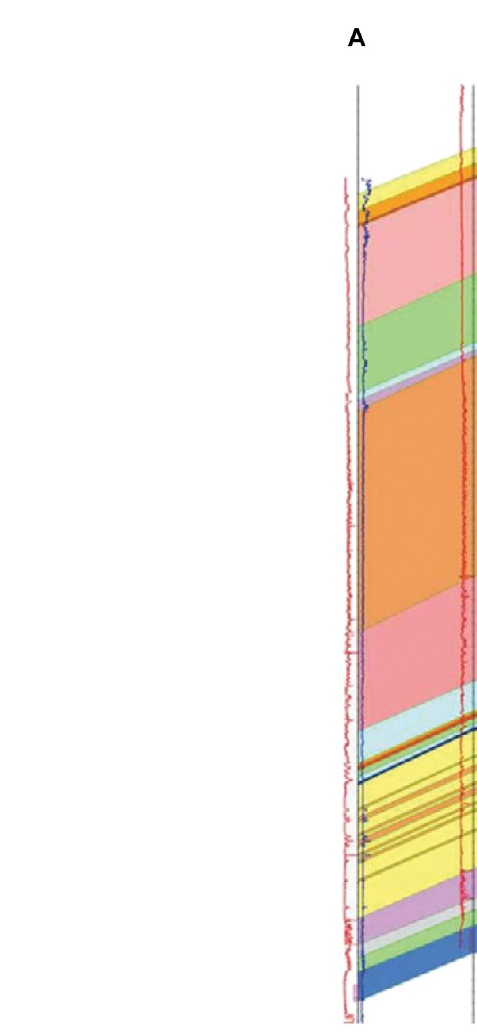
FIGURE 3 Simpli fi ed cross-section of the McElmo Dome (Stevens, 2005), illustrating the geometric arrangement of the carbonate reservoir (Leadville Limestone) containing